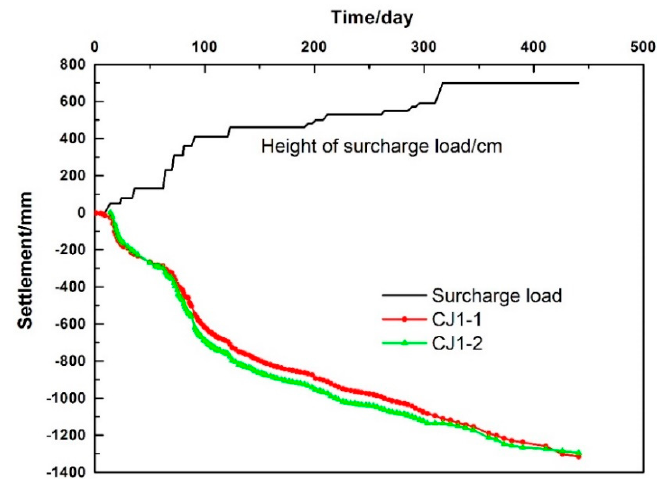
Figure 5. Variation of settlement and embankment filling height of the K12 + 850 section in the field test.